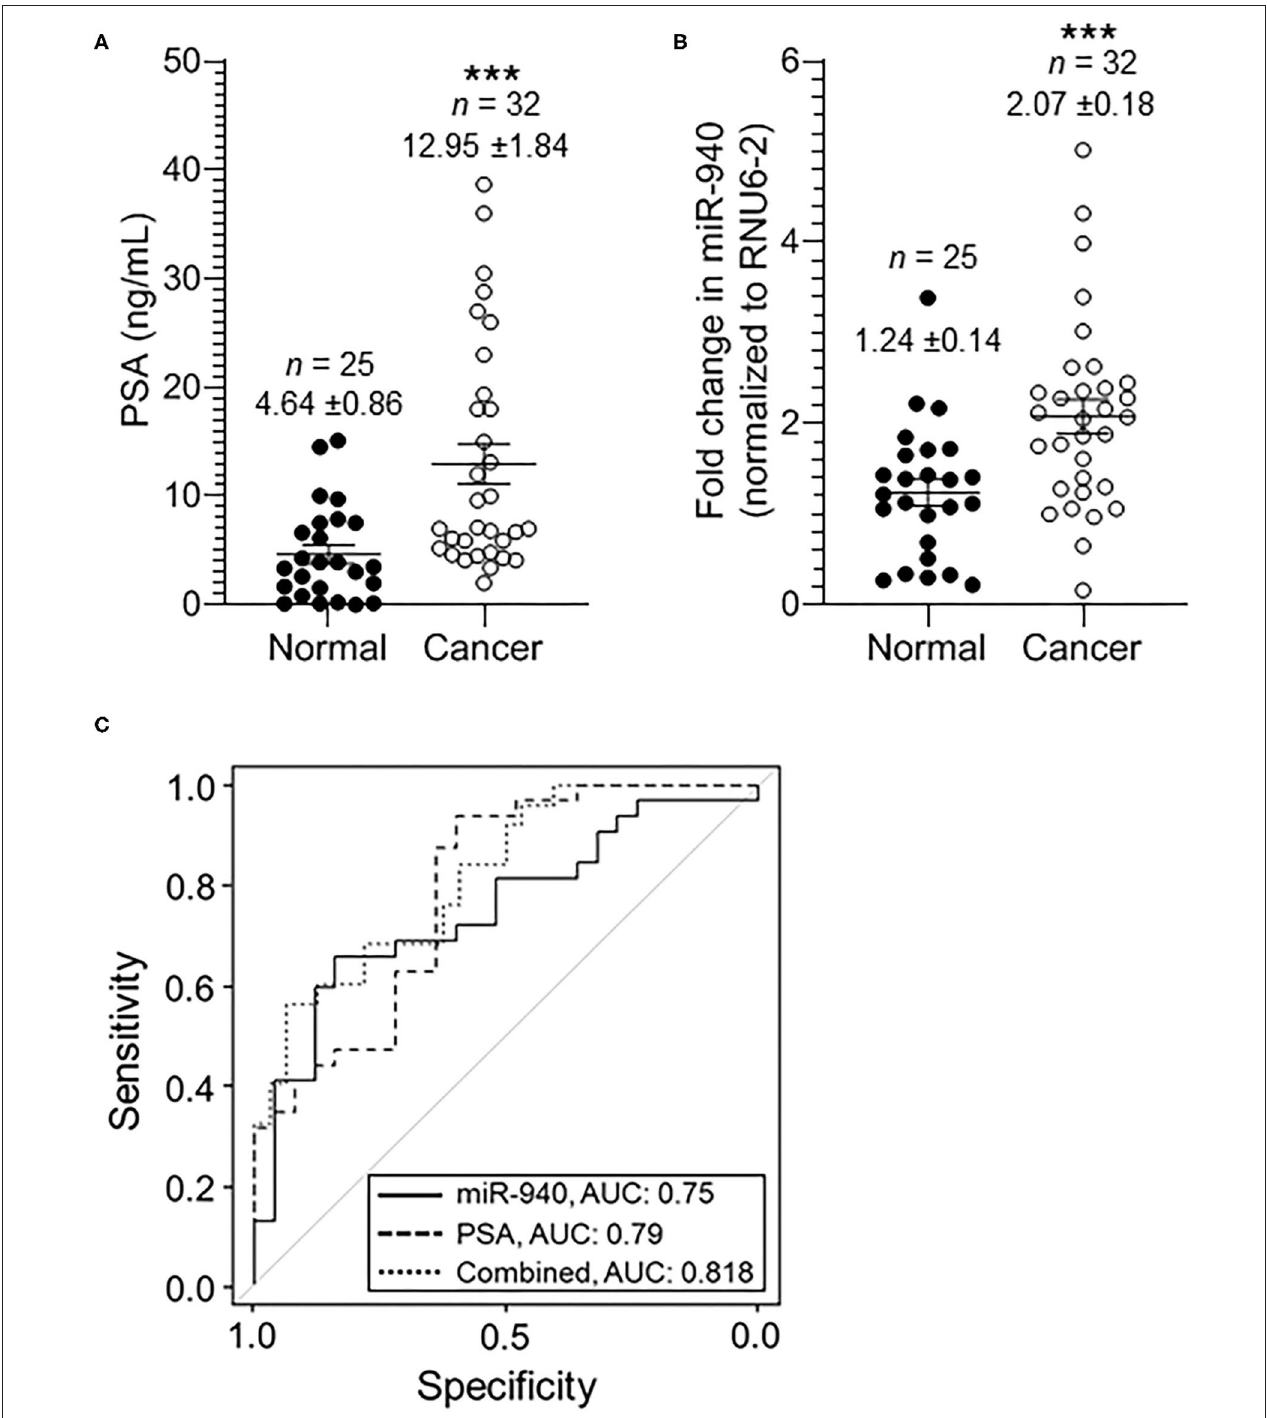
FIGURE 2 | The expression of miR-940 and PSA in serum samples of prostate cancer patients and normal healthy males. (A) Scatter plot analysis of PSA expression in serum samples of normal healthy ( n = 25) controls and prostate cancer ( n = 32) patients. The data are expressed as the mean ± SEM (*** p -value = 0.0005; two-tailed Student’s t -test). (B) Scatter plot analysis of miR-940-fold expression in serum samples of healthy normal controls ( n = 25) and prostate cancer patients ( n = 32). The data are expressed as the mean ± SEM (*** p- value = 0.0013; two-tailed Student’s t -test). (C) ROC curve for (B) depicts the sensitivity (true positive: cancer in reality and according to test variable; i.e., fold change in miR-940) and specificity (100%—false positive: 100%—normal in reality with fold change in miR-940 predicting cancer) for the use of secreted miR-940 as an independent variable to determine cancer vs. normal states. The AUC values are shown on the graph.